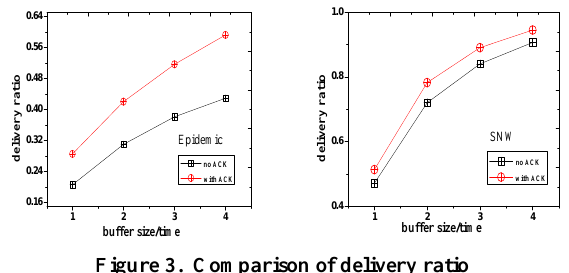
Figure 3. Comparison of delivery ratio